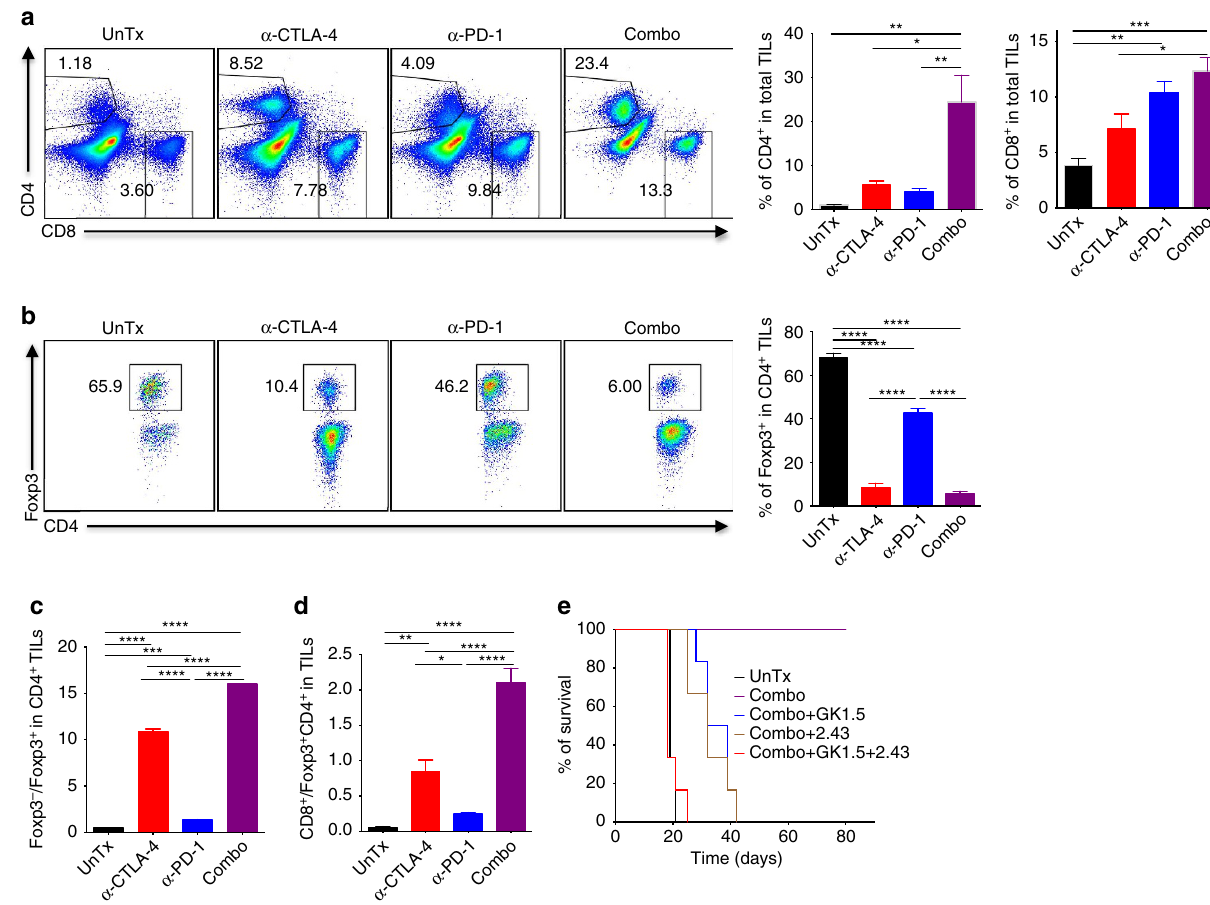
Figure 3 | Combination therapy-mediated MB49 tumour rejection is dependent on CD4 þ and CD8 þ T cells. Isolated TILs from 13–15days tumours, 1–3 days after the last treatment with a -CTLA-4, a -PD-1, combination of both (Combo) were analyzed by flow cytometry for ( a ) Total CD4 þ T cells and CD8 þ Tcells. Representative flow panels are shown on the left and pooled results from five mice are depicted in bar graphs on the right. ( b ) Foxp3 þ T reg in CD4 þ Tcells. Pooled results from five mice are shown in the right bar graph. ( c ) Ratios of Foxp3 (cid:3) to Foxp3 þ in CD4 þ Tcells. ( d ) Ratios of CD8 þ Tcells to Foxp3 þ CD4 þ Tcells. Mice depleted of CD4 þ (GK1.5), CD8 þ (2.43) or both (GK1.5 þ 2.43) were treated with the combo and mouse survivals are presented ( e ). Data in the bar graphs are means ± s.e.m. * P o 0.05; ** P o 0.01; *** P o 0.001; **** P o 0.0001 by one-way ANOVA with Bonferroni’s post hoc test. Data are representative of three independent